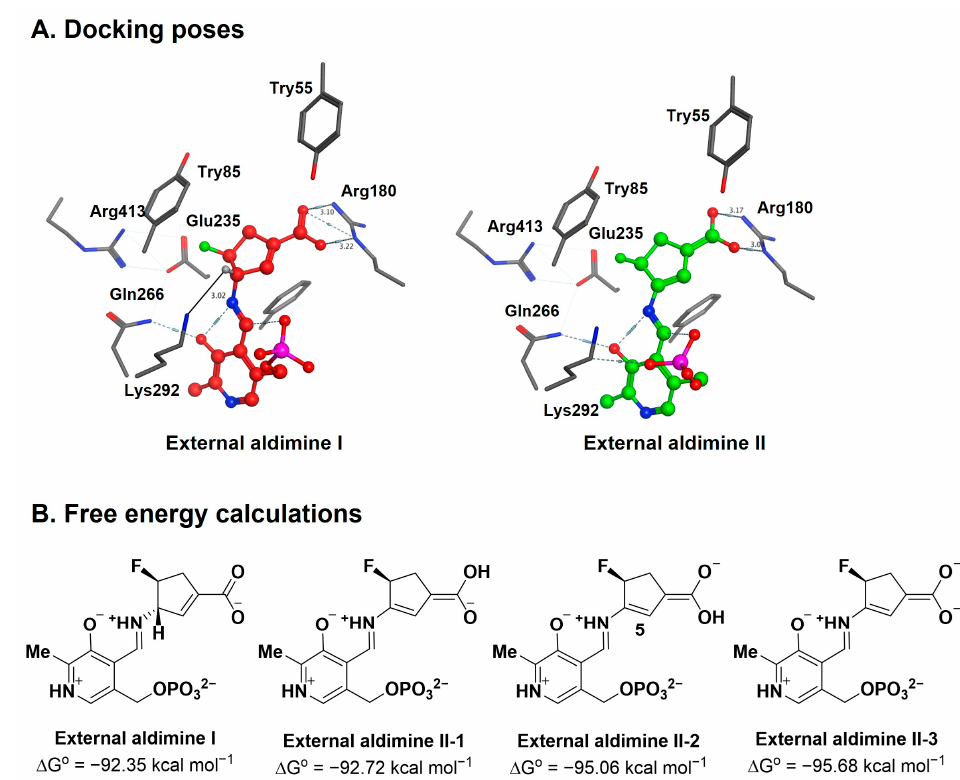
Figure 9. ( A ) Molecular docking poses and ( B ) free energy calculations of potential external aldimines I and II.